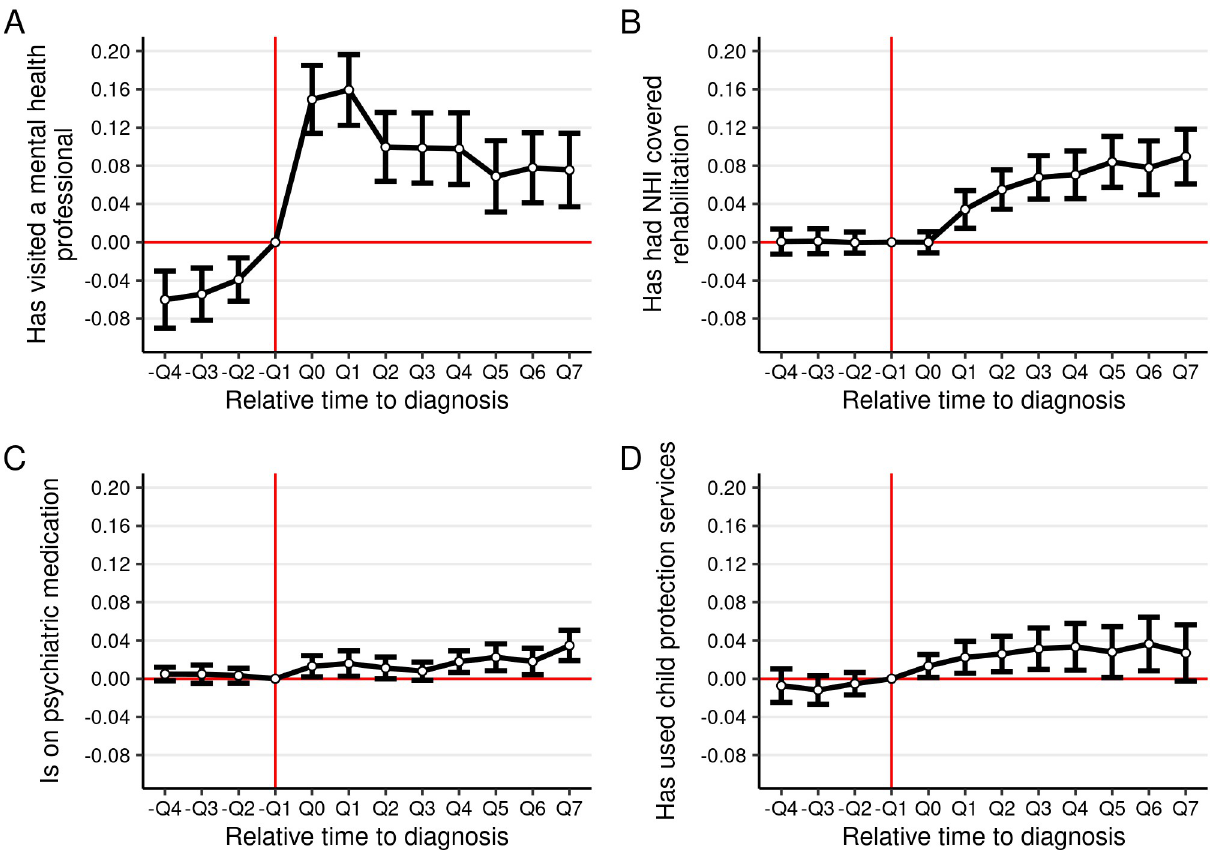
Fig 3. Event study regressions for service utilization. Y-axis shows the probability of utilization of the respective service. Service utilization is measured with a binary variable equaling one when the respective service was utilized and zero when not utilized. − Q 1 is the omitted event dummy and coefficients are thus normalized with respect to this event-period. Controls used in the regressions include fixed effects for the common time trend, age, and sex.